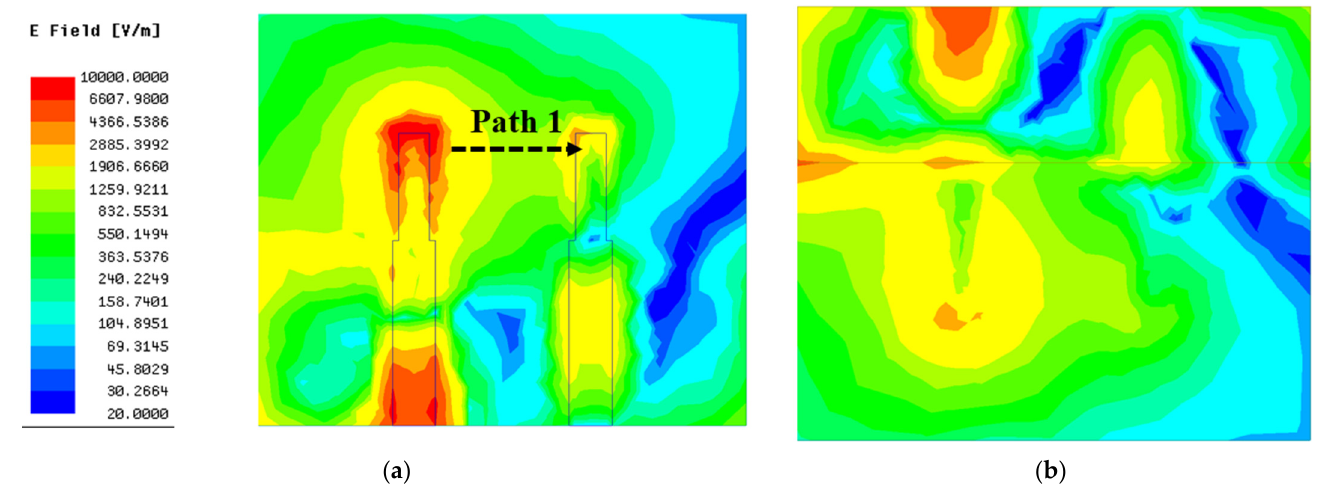
Figure 5. The surface electric field distribution of antenna 1: ( a ) top surface; ( b ) bottom surface.